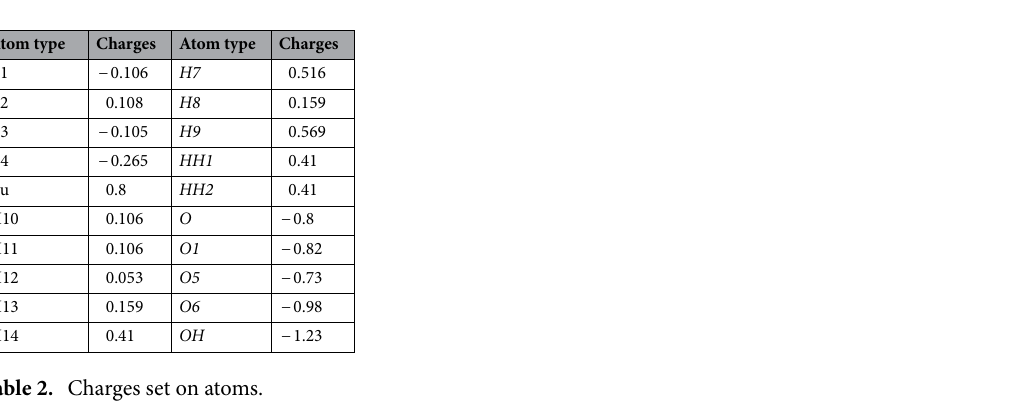
Table 2. Charges set on